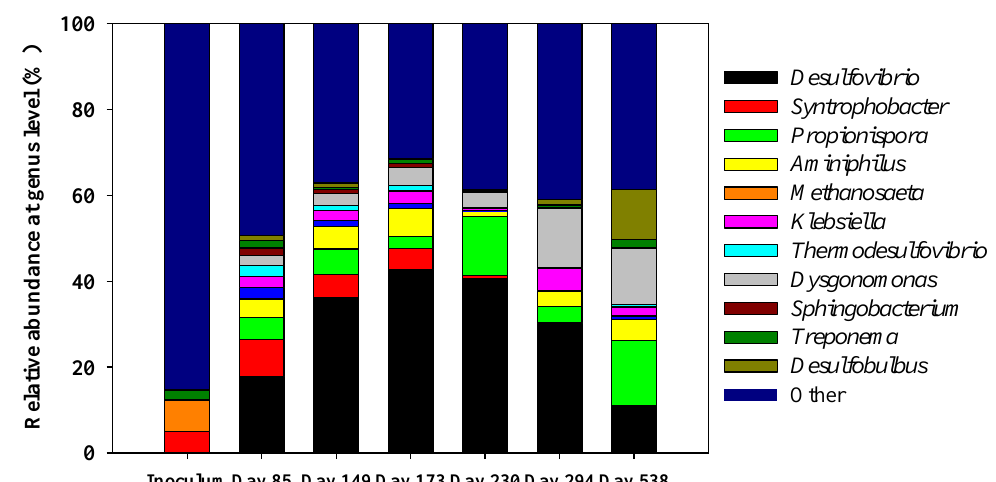
Figure 3. Relative abundances (%) at genus level of all the different samples along the operation of the reactor.